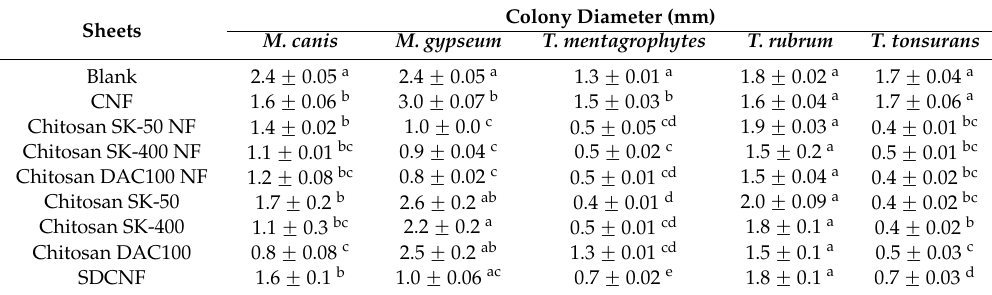
Table 2. Antifungal activity of chitosan nanofibers (NFs) on mycelial growth of dermatophytes. Sheets